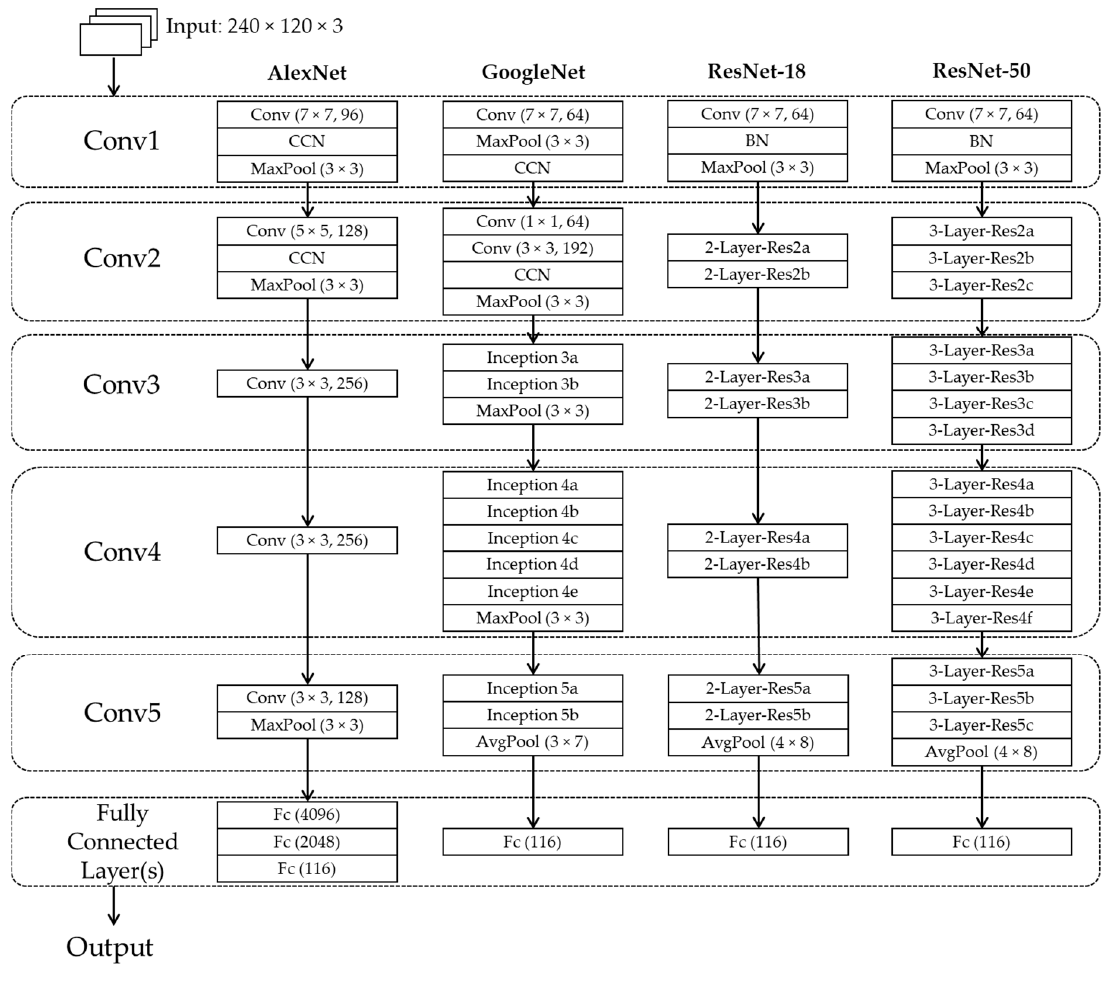
Figure 3. Convolutional neural network (CNN) architectures used for comparisons in our research.